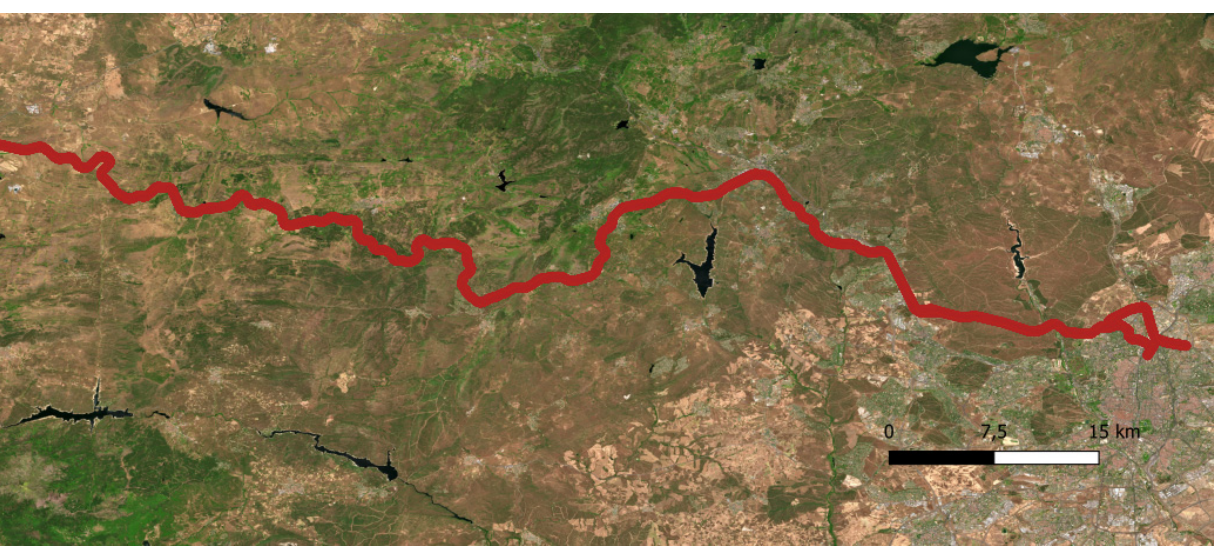
Figure 1. Casa study data. 90 km of railway section.